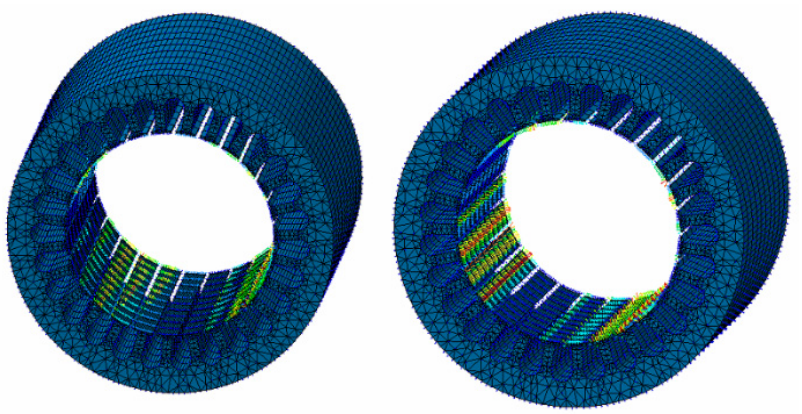
Figure 2. Radial forces acting on the inner surface of the stator: machine with skew ( left ) and machine without skew ( right ).